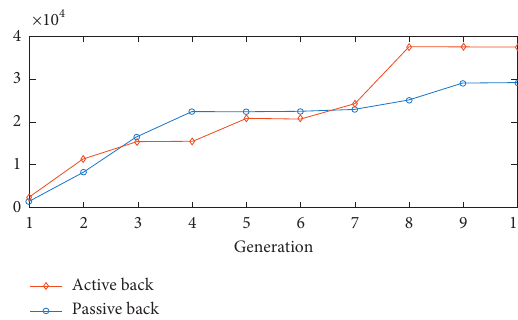
Figure 8: Comparing performances of the case of an active back joint (diamond markers) and the case where the back joint is passive (circle